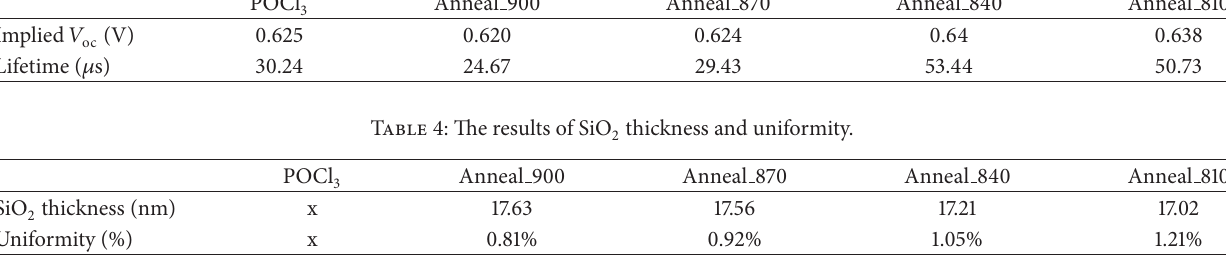
Table 3: Implied 𝑉